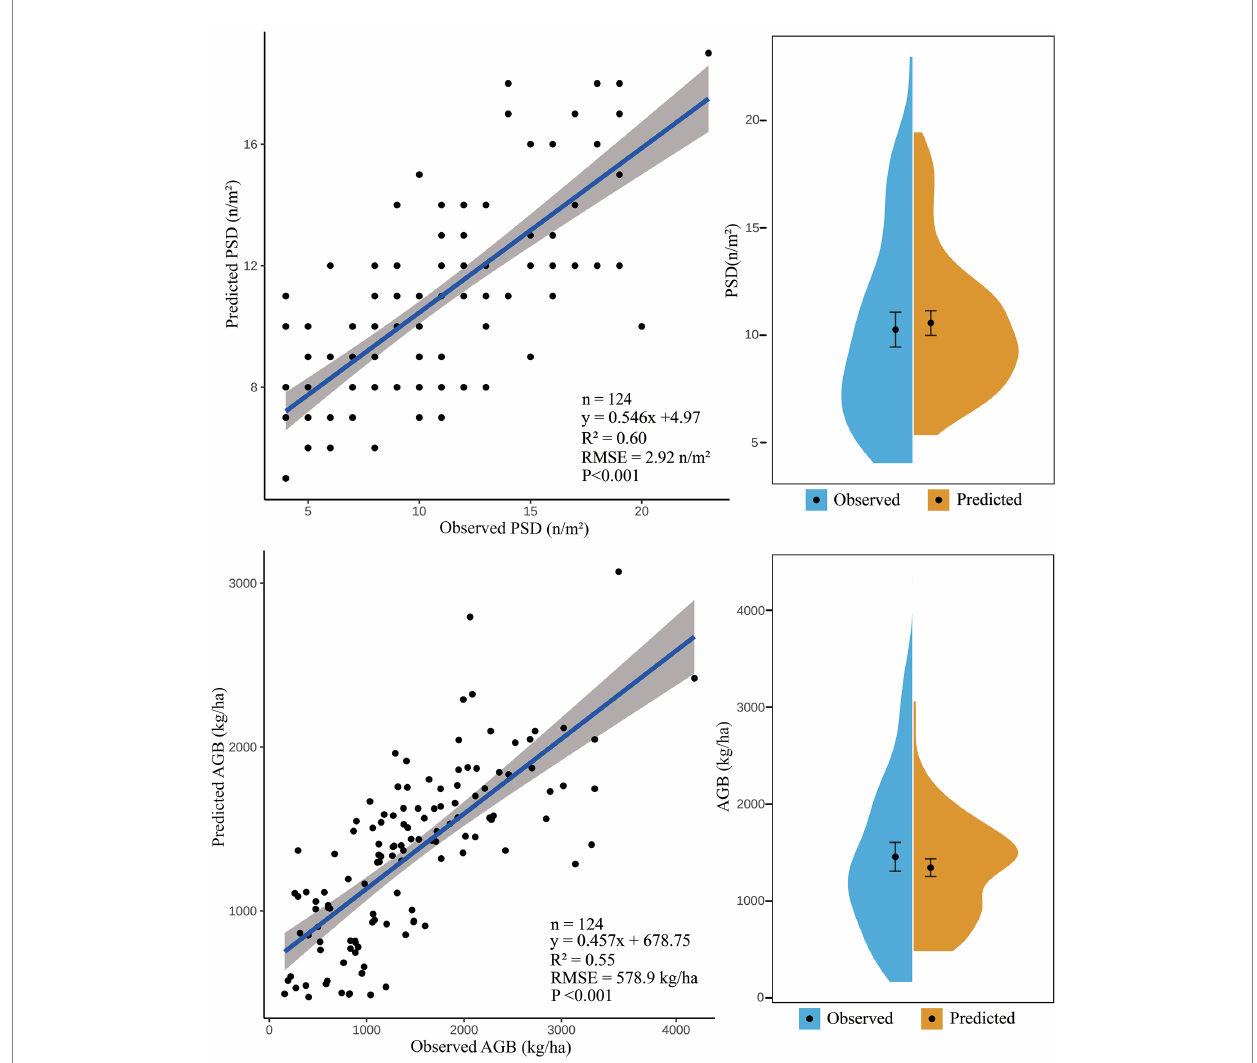
FIGURE 2 Comparison of the measured values of PSD and AGB with the predicted values of the optimal